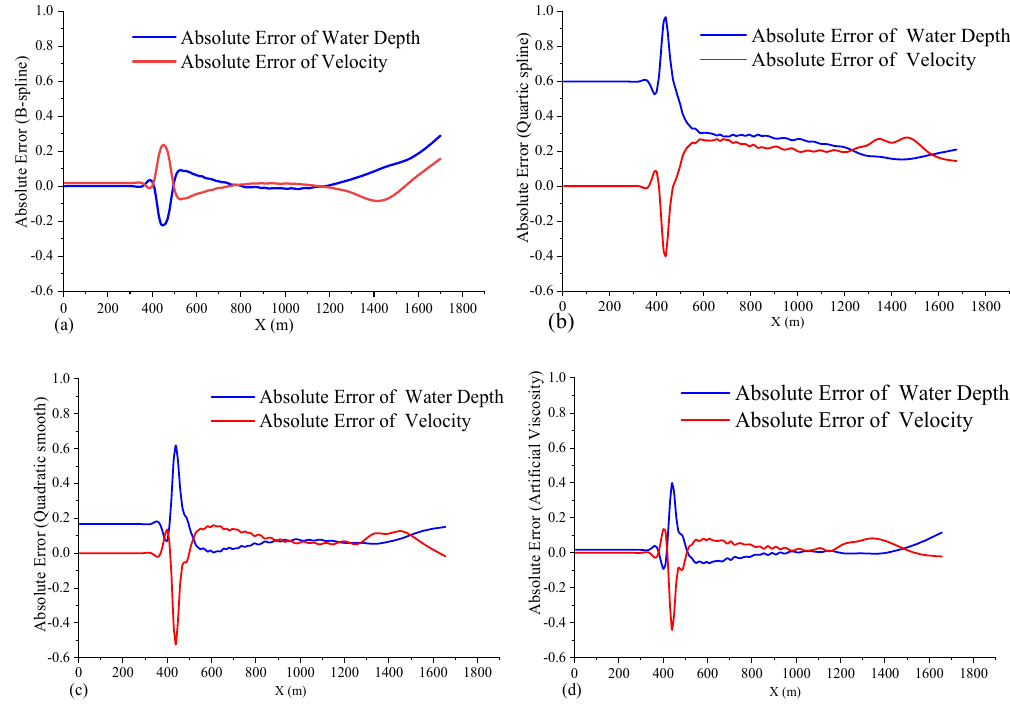
Figure 2. Absolute errors of different kernel functions and processing methods. ( a – c ) The absolute errors of water depth and velocity calculated by B-spline kernel function, quartic spline, and quadratic spline kernel function, respectively. ( d ) The absolute errors of water depth and velocity calculated by using the artificial viscosity method.